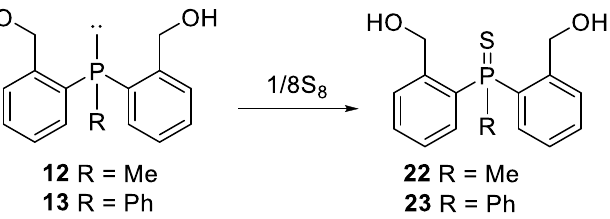
Table 2. Desymmetrisation of bis (2-hydroxymethylphenyl)phosphine sulfides 22 and 23. Entry